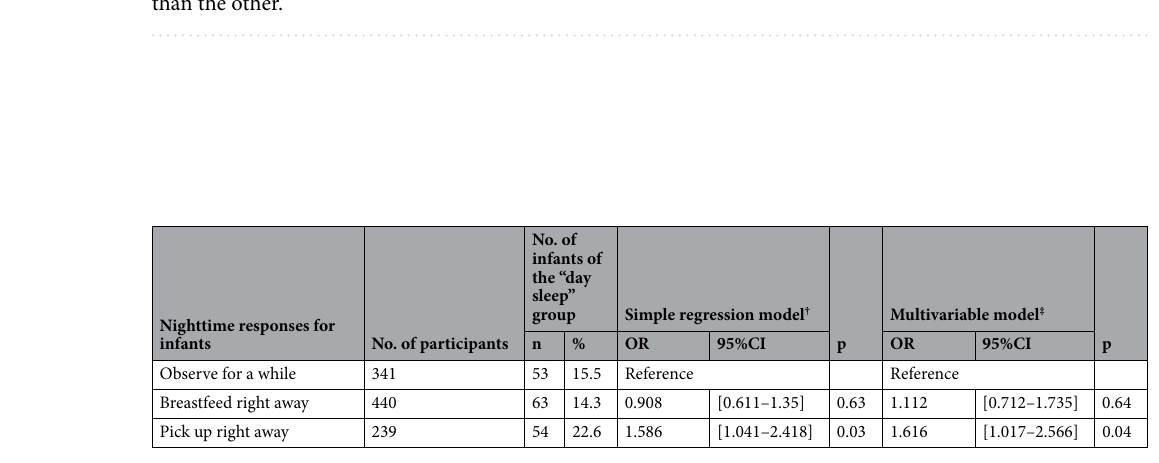
Table 3. Impact of nighttime responses on the daytime sleep of the infants in the “Day sleep” group. Logistic regression analysis. Nighttime responses for infants were analyzed by excluding the “Other” response group (n = 113). OR Odds ratio, CI Confidence interval. † Only the nighttime response was entered as